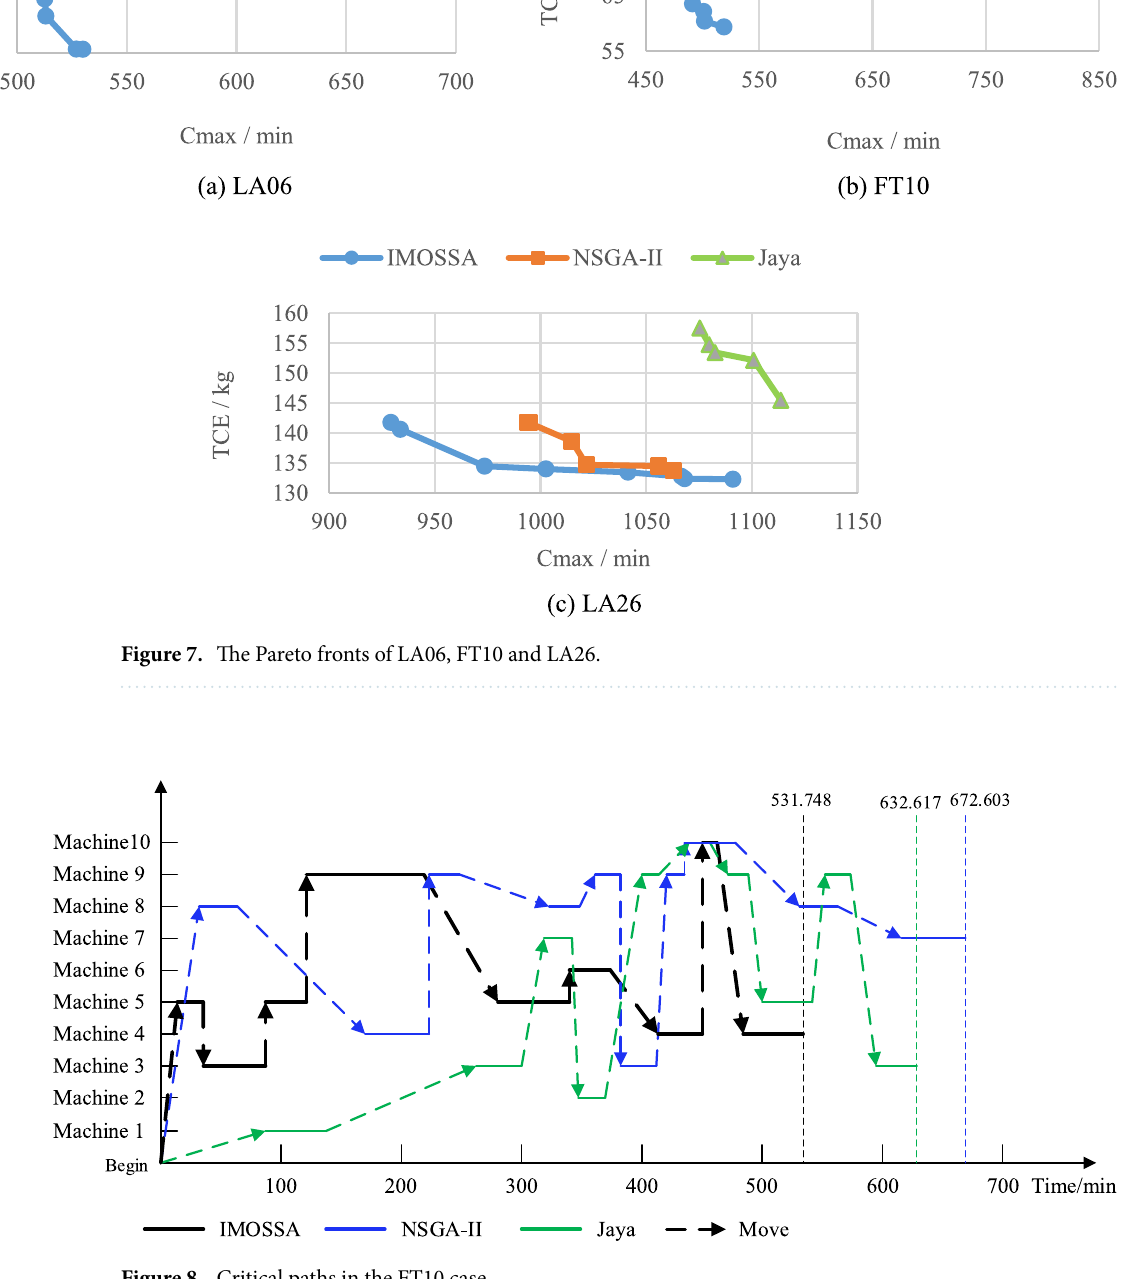
Figure 8. Critical paths in the FT10